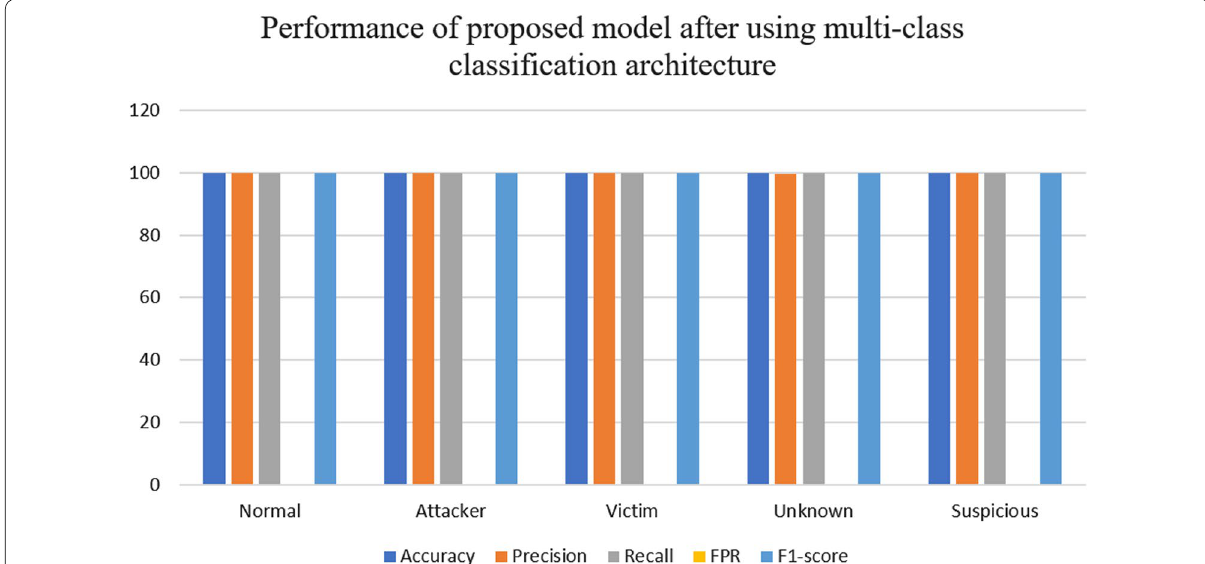
Fig. 11 Graphical representation for evaluation results of proposed model after using multi-class classification on CIDDS-001 dataset for five classes of Normal, Attacker, Victim, Suspicious and Unknown for F1-score, FRP, Recall, Precision and Accuracy